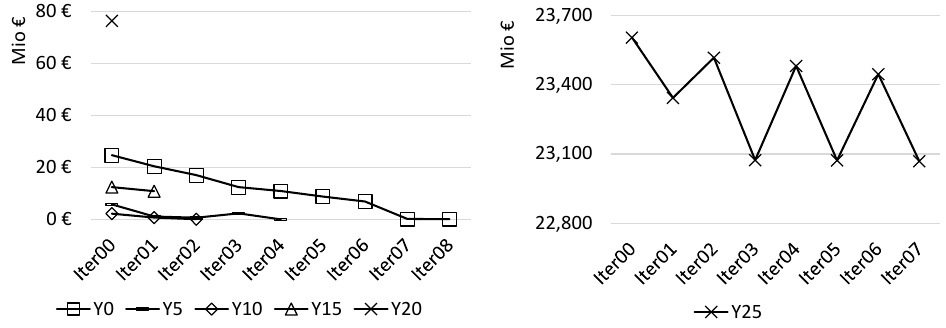
Figure 9. Change of uncovered fixed costs over iterations (myopic).